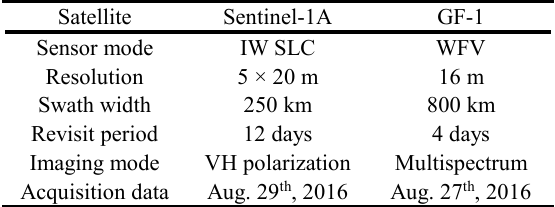
Table 1. Margin settings for A4 size